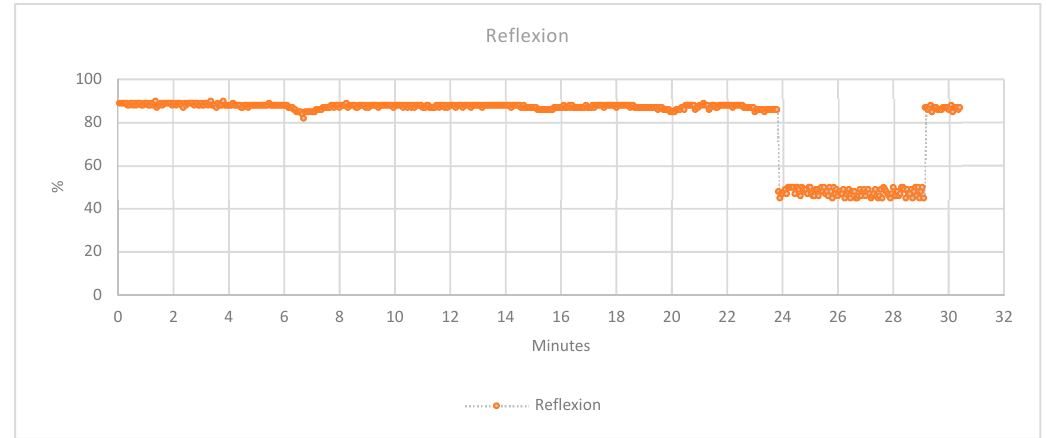
Figure 14. Collected data of the light reflection sensor over the skin.